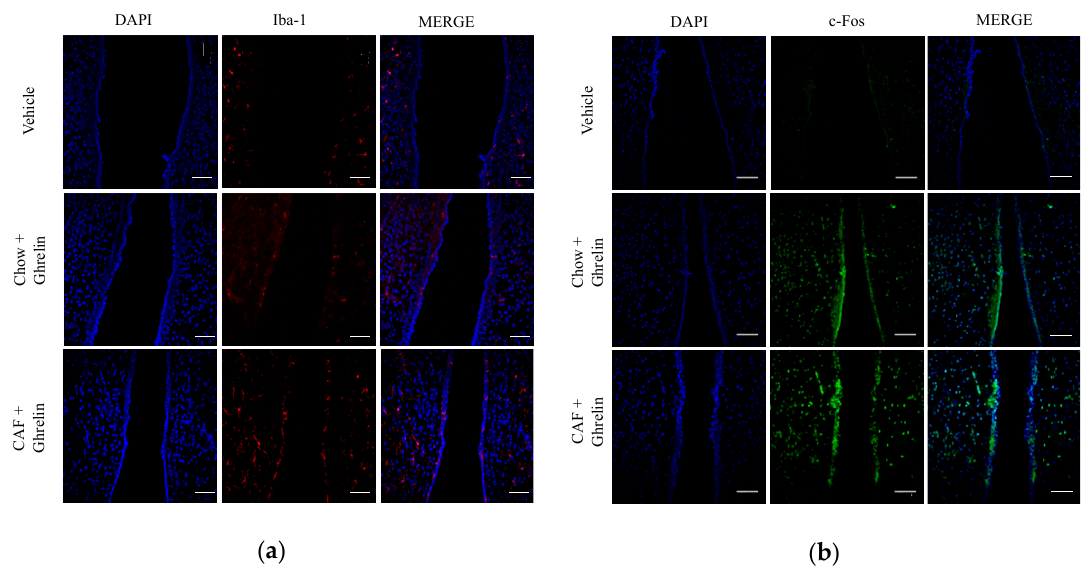
Figure 2. Maternal programming leads to microglia activation and c-Fos response in hypothalamus. Offspring was programmed by CAF diet exposure as previously described, and 0.2 micrograms/kg ghrelin was intradermically administered, and subjects were intracardially perfused with 0.1M PBS + heparin followed by PBS + 4% PFA. Hypothalamic sections were obtained using a cryostat, according to the Paxinos and Watson Atlas. Immunofluorescence to identify microglia activation was performed using the Iba-1 antibody (1:200) following by the secondary antibody Alexa Fluor 546 Goat